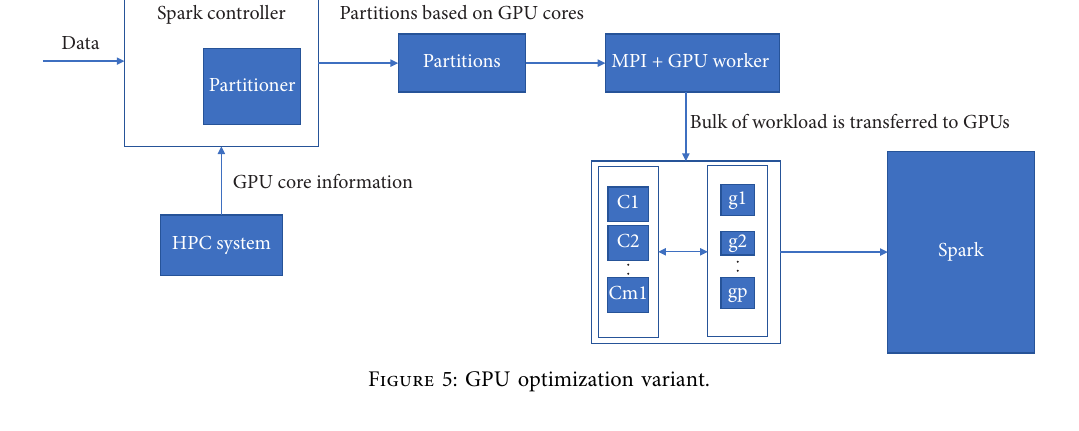
Figure 5: GPU optimization variant.